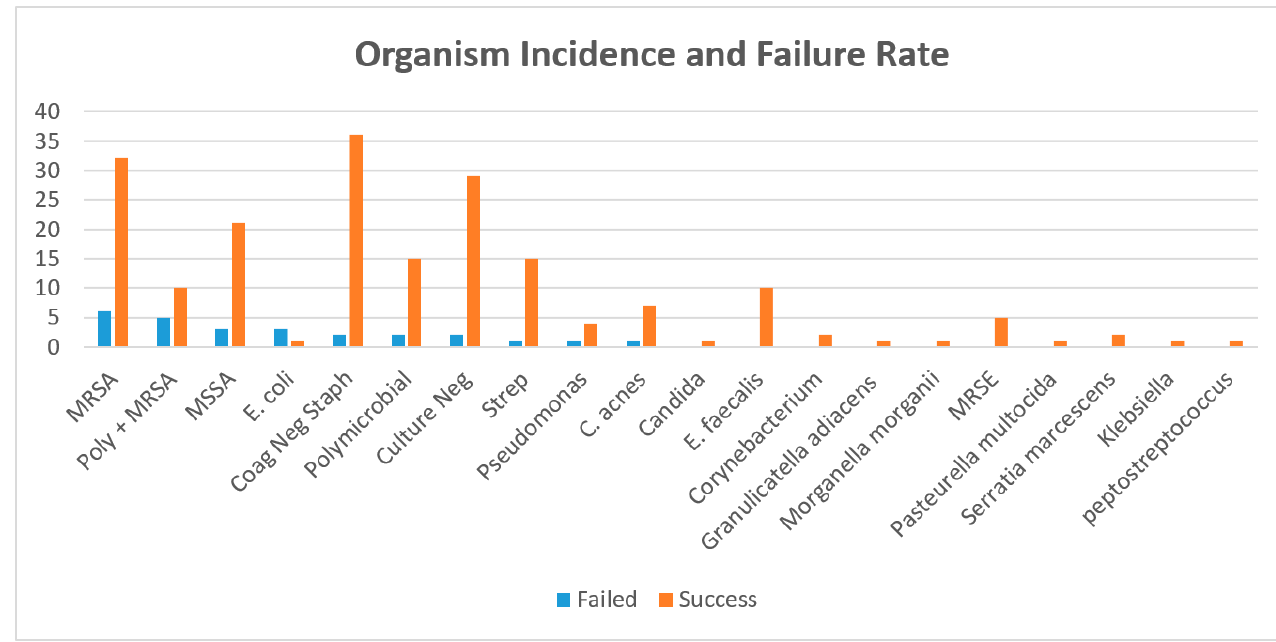
Figure 2. Organism Profile (%Failure). Associated MRSA infection yielded 20.75% failure rate.